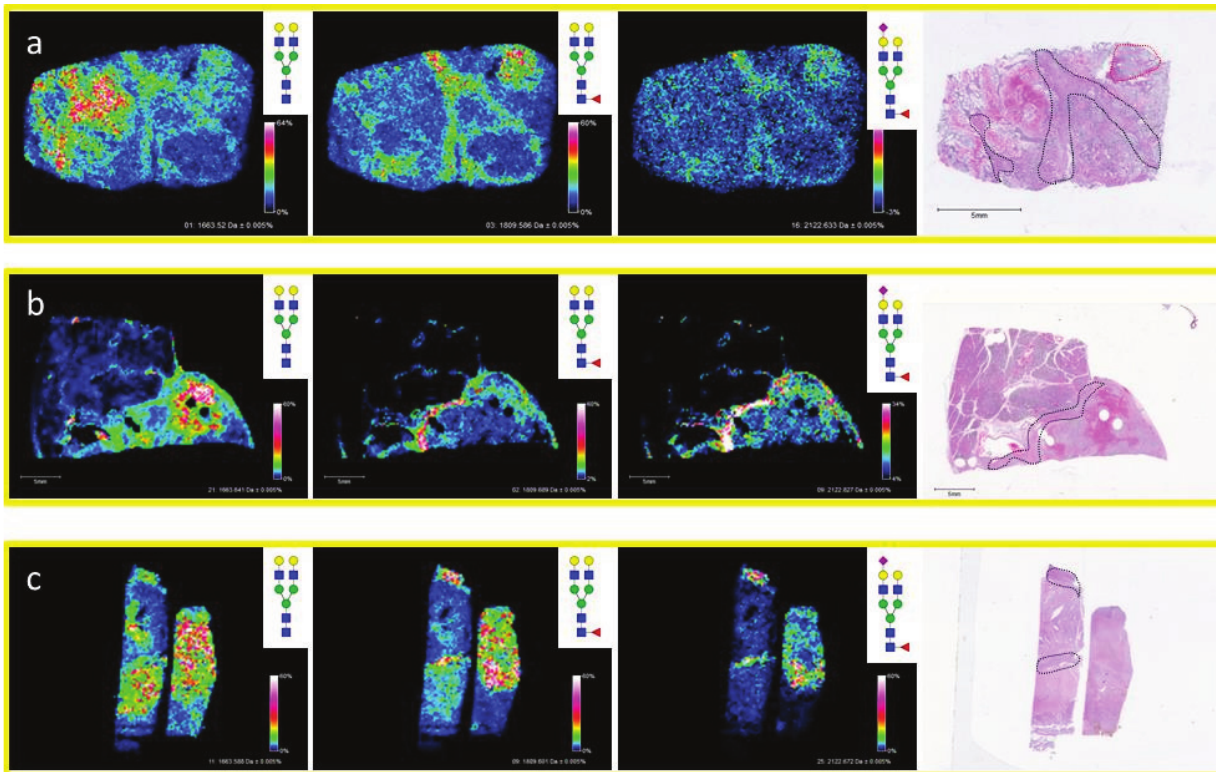
Figure 3. Diverse Organs with Similar Properties Display Conserved Glycan Patterns. Fibrous tissue from three diverse tissue types were analyzed by MALDI-IMS and shared similar N -glycan properties. Shown are images from lymph tissue with a ccRCC metastasis ( a ); pancreatic cancer tissue with complex histopathology ( b ); and liver tissue with complex histopathology ( c ). In each tissue, the ions corresponding to Hex5HexNAc4 ( m / z = 1663.582 + Na), Hex5dHex1HexNAc4 ( m / z = 1809.661 + Na), and Hex5dHex1HexNAc4NeuAc1 ( m / z = 2122.720 + 2Na) display similar localization patterns with each being elevated in the fibrous tissue regions. Fibroconnective tissue regions are outlined in black on the H & Es while fibrotic ccRCC tumor tissue is outlined in red. The core fucosylation in the indicated structures has yet to be confirmed by other